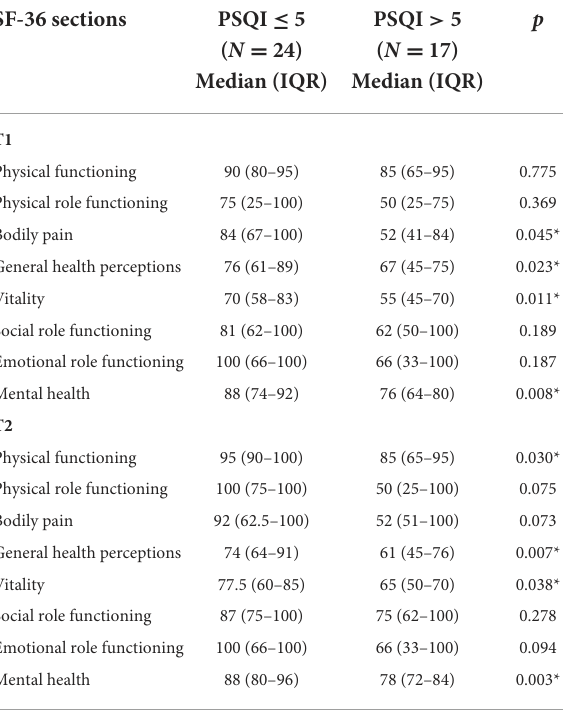
TABLE 4 Univariate linear regression for PSQI total score at T1 study visit.